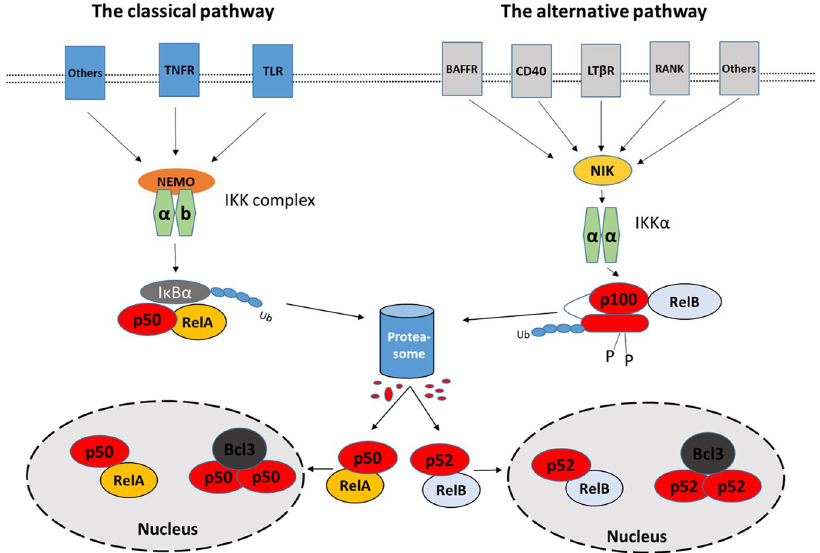
Figure 1. The two major NF- κ B pathways (classical and the alternative). The activation of the classical pathway mainly leads to the formation of an active heterodimer of p50:RelA, which modifies multiple gene expression by binding to κ B binding sites. The alternative pathway regulates gene expression through the binding of the central complex p52:RelB. Many other heterodimers and homodimers of p50 and p52 are formed increasing further the complexity of the NF- κ B system. Abbreviations: TLR; Toll-like receptors, TNFR; Tumor necrosis factor receptor, NEMO; NF-kappa-B essential modulator, I κ B; nuclear factor of kappa light polypeptide gene enhancer in B-cells inhibitor, BAFFR; tumor necrosis factor receptor superfamily member 13 C, CD40; CD40 molecule, TNF receptor superfamily member 5, LT β R; Lymphotoxin Beta Receptor (TNFR Superfamily, Member 3), RANK; Receptor Activator Of Nuclear Factor-Kappa B, NIK; NF-Kappa-Beta-Inducing Kinase, IKK α ; I κ B Kinase α , IKKb; I κ B Kinase b, p100; nuclear factor NF-kappa-B p100 subunit, p52; nuclear factor NF-kappa-B p52 subunit, RelB; Transcription factor RelB, Bcl3; B-Cell CLL/Lymphoma